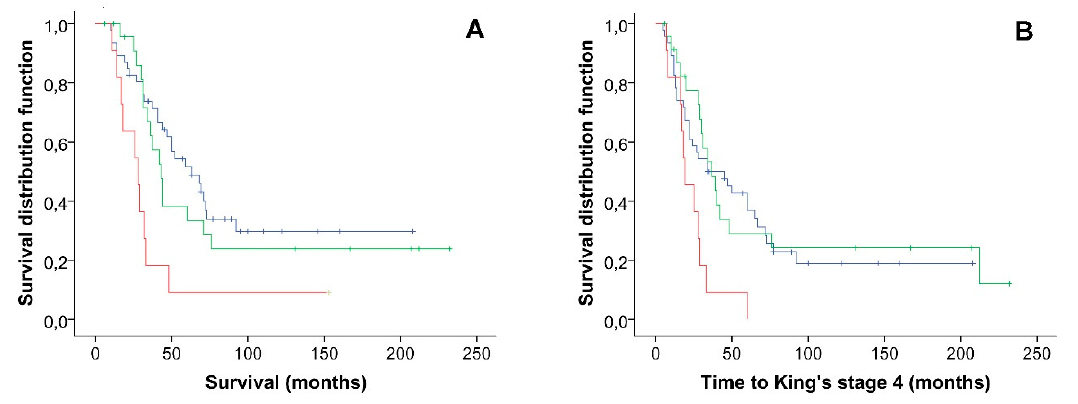
Figure 2. Kaplan–Meier univariate analysis for Survival ( A ) and time to reach King stage 4 ( B ). Black line, patients harboring no variants; green line, one rare variant; red line, two or more rare variants.